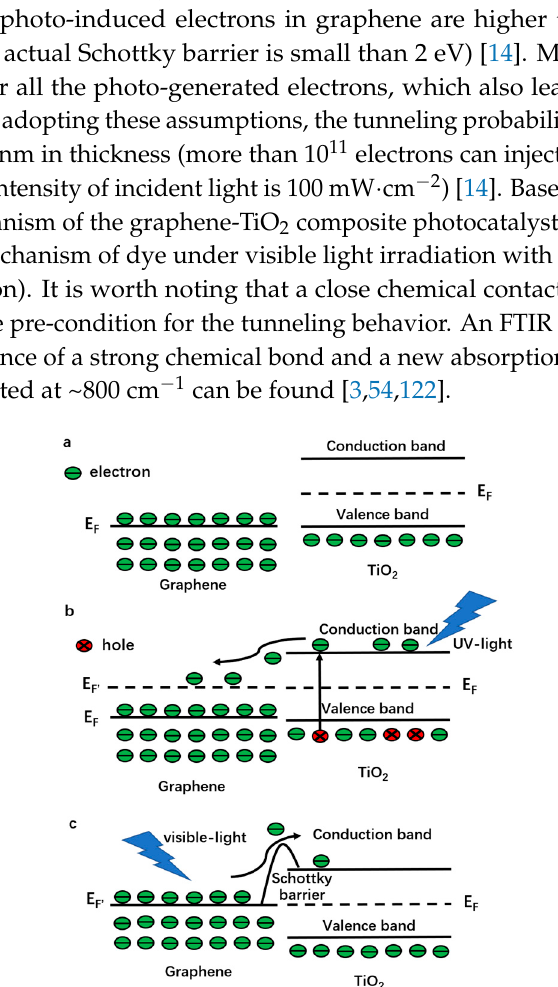
Figure 4. Band structures and interface interactions of the graphene-TiO 2 ( a ) before combination ( b ) under UV-light irradiation and ( c ) under visible light irradiation with a close chemical contact.